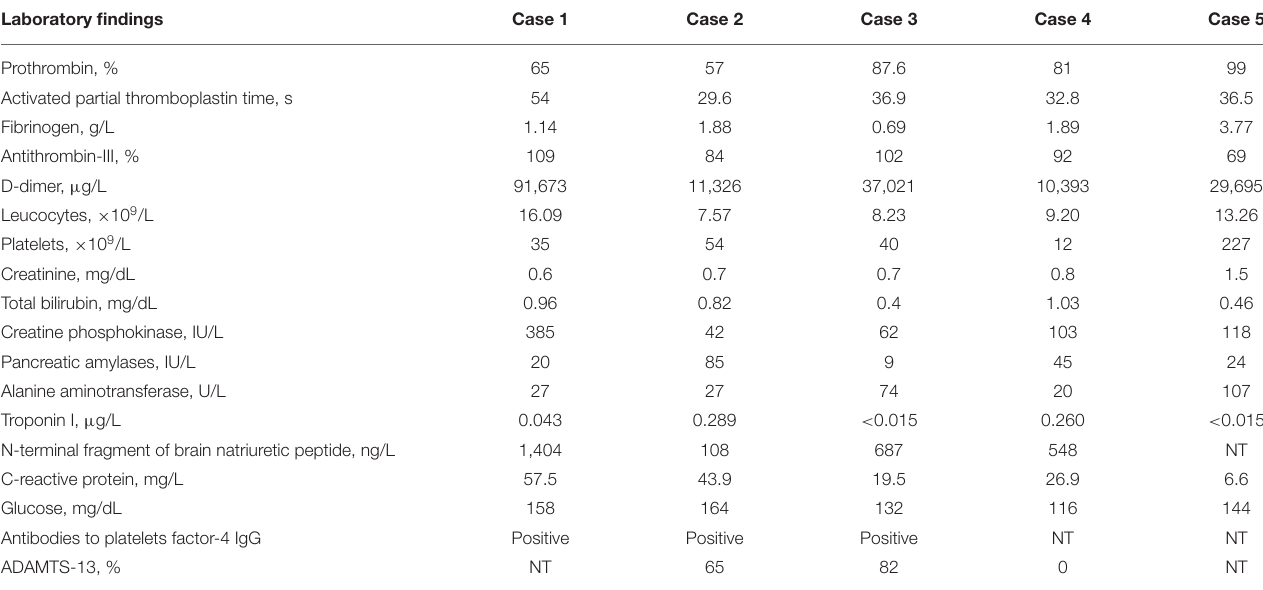
TABLE 1 | Laboratory findings at hospital